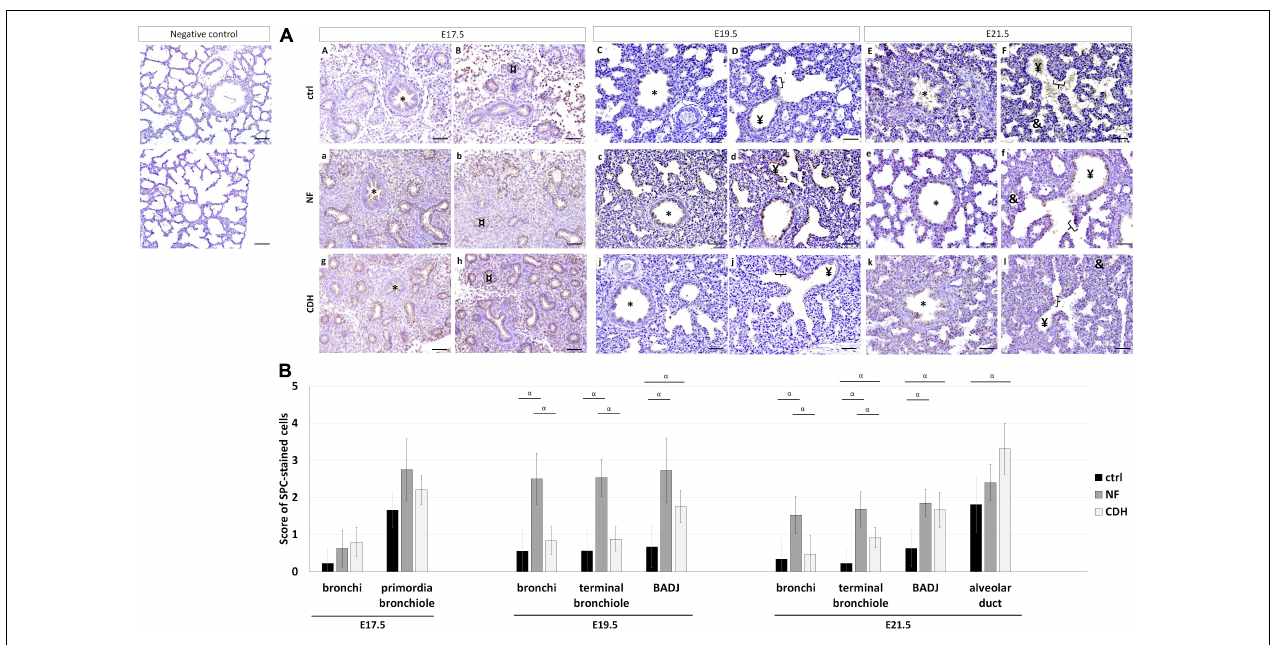
FIGURE 5 | Expression profile of surfactant protein-C (SP-C) in the normal and induced congenital diaphragmatic hernia (CDH) rat model. Representative immunohistochemical evidence for SP-C expression at (AA,B,a,b,g,h) embryonic day, (E)17.5, (AC,D,c,d,i,j) E19.5, and (AE,F,e,f,k,l) E21.5 of normal (ctrl), nitrofen (NF), and CDH phenotypes, respectively. *Bronchiole; ¤ primordia of bronchiole; (cid:85) terminal bronchiole; [bronchioalveolar duct junction; & alveolar duct. Scale bar 50 µ M. (B) Semi-quantitative analysis of SP-C expression from pseudoglandular-to-saccular stages in control, NF, and CDH lungs. Results are presented as mean µ SD. Symbols indicate the main effects and non-redundant interactions of T -test for independent samples. α p <